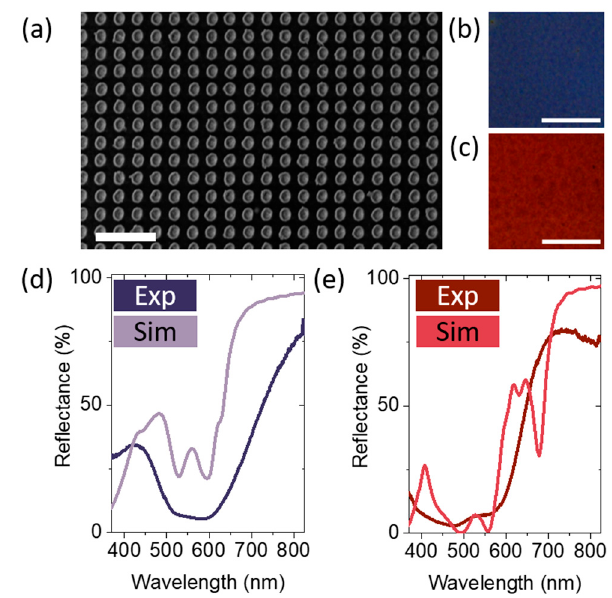
Figure 5. Experimental realisation: ( a ) SEM image of a representative nanodisc array (with 175 nm diameter discs and 300 nm pitch). Scale bar is 1 µ m. ( b , c ) Optical microscope images (at 100 × magnification) for the samples with polymer thicknesses of 70 nm and 196 nm, respectively. The white scale bars are 20 µ m ( d , e ) Experimental and calculated reflectance spectra for polymer thicknesses of 70 nm and 196 nm, respectively. The spectra are presented in the corresponding sRGB colour.